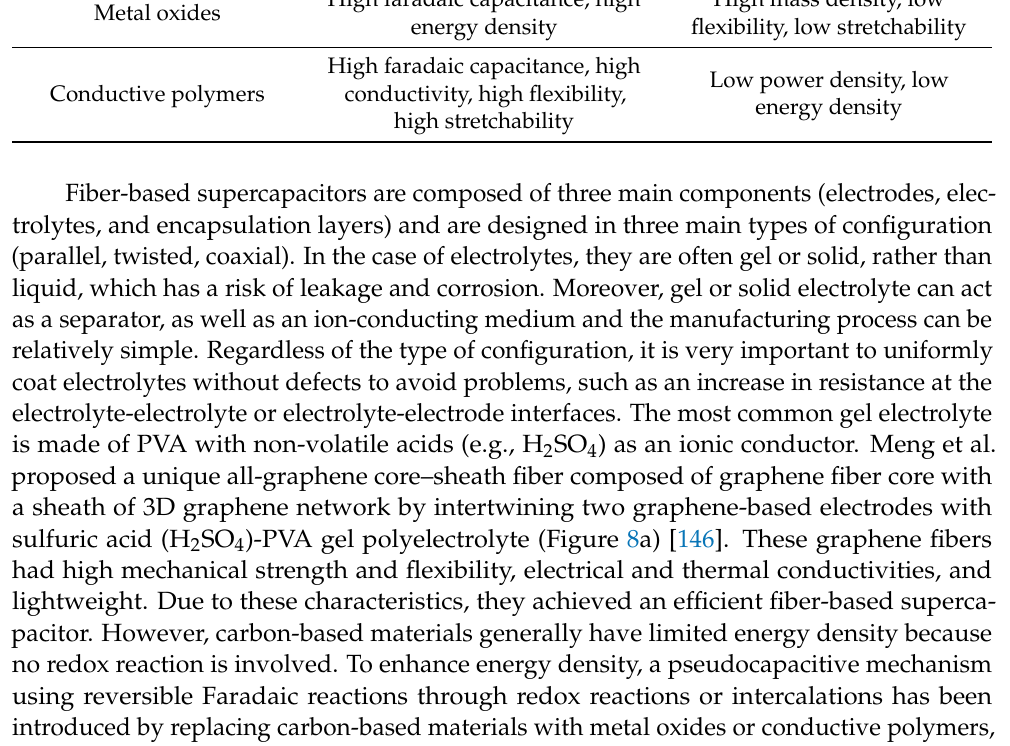
Table 4. Characteristics of electrode materials for supercapacitors. Materials of Electrodes Strengths Weaknesses High conductivity, chemical High faradaic capacitance, stability, long cycle life, low mass high energy density, high Carbon-based materials density, good stretchability, large specific surface area throughputs, High faradaic capacitance, high High mass density, low Metal oxides energy density flexibility, low stretchability High faradaic capacitance, high Conductive polymers conductivity, high flexibility, energy high stretchability